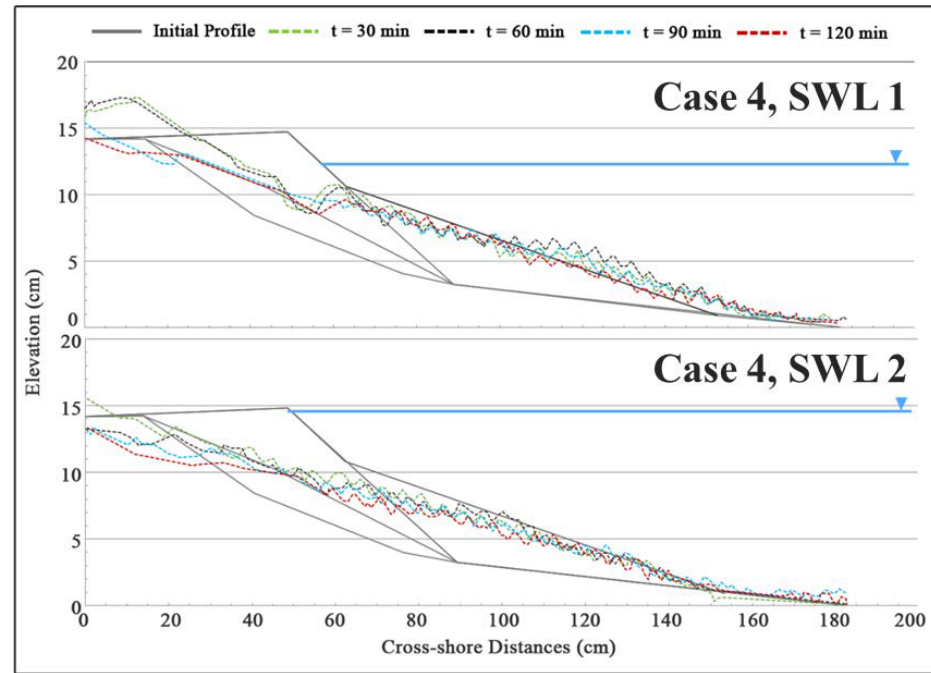
Figure 11. Case 3: BGL with SWL 1 and SWL 2 profile evolution of t 1 , t 2 , t 3 , and t 4 .